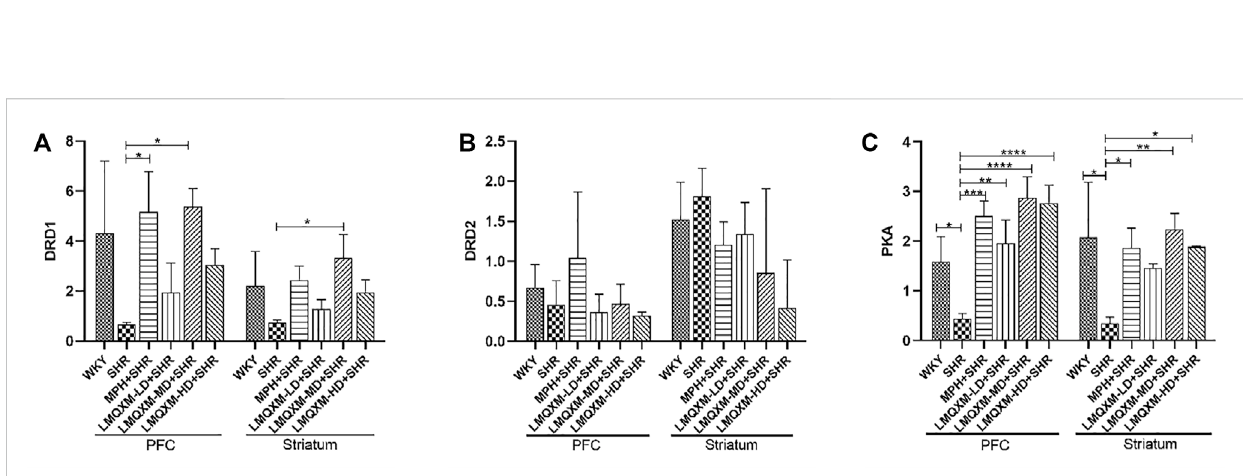
FIGURE 9 The mRNA expression of DRD1, DRD2, and PKA in PFC and striatum (A) DRD1 mRNA expression (B) DRD2 mRNA expression (C) PKA mRNA expression. All data are presented as mean ± SD, n = 3 for each group. * p < 0.05, ** p < 0.01, *** p < 0.001, **** p < 0.0001.